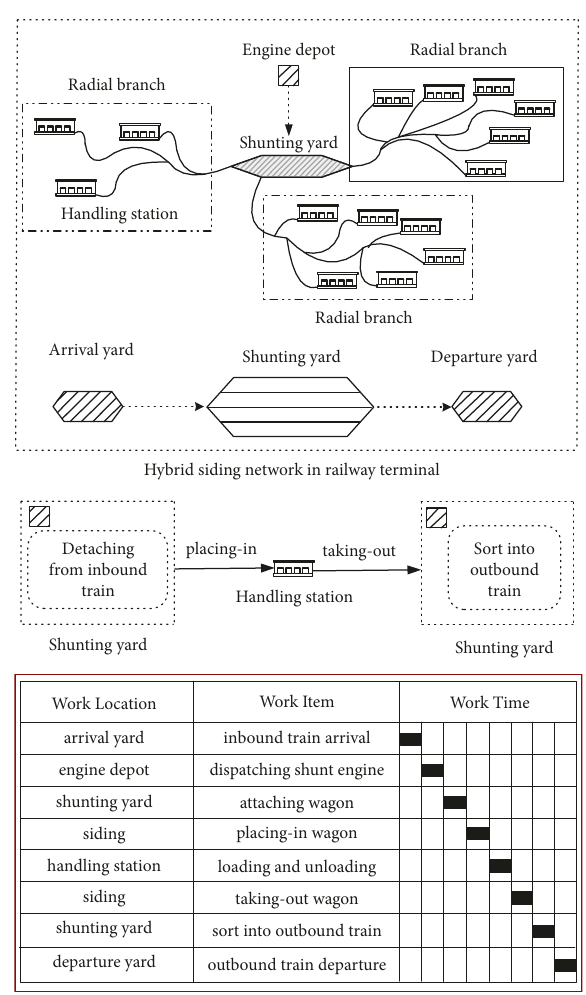
Figure 1: Illustration of the process for delivery and pickup wagons on hybrid siding